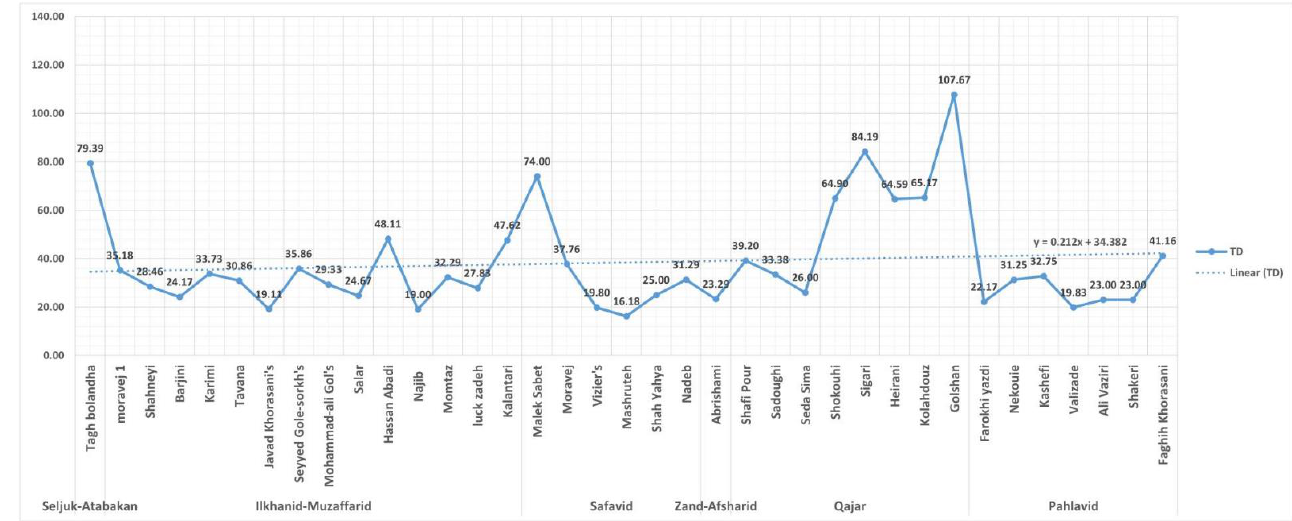
Figure 8. Total Depth ( TD ) results and trendlines for the 37 houses, presented chronologically by era.